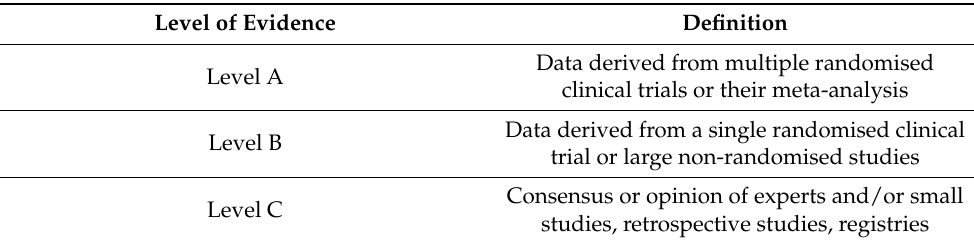
Table 1. Classification of the level of